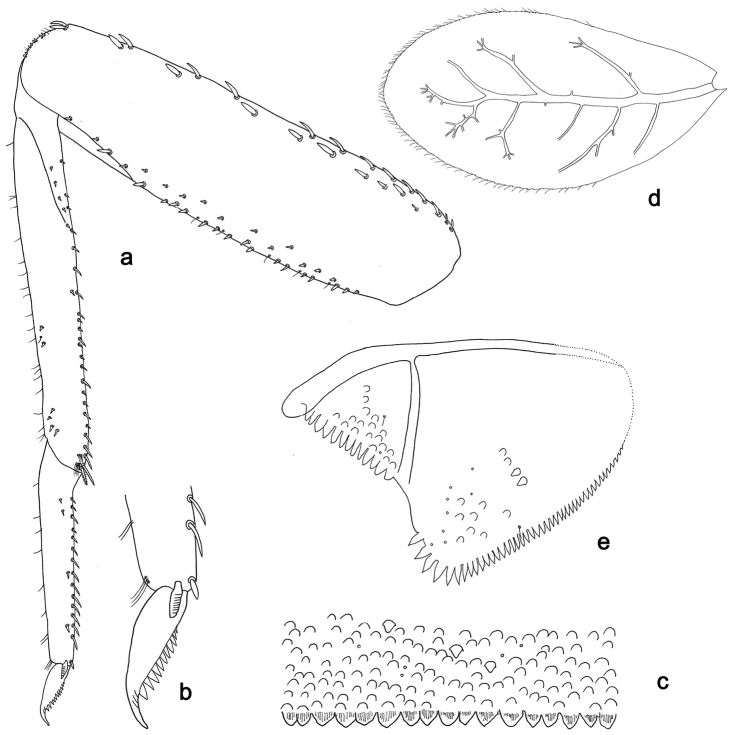
Labiobaetisparavitilis sp. n., larva morphology: aForelegb Fore claw cTergum IV d Gill IV eParaproct.